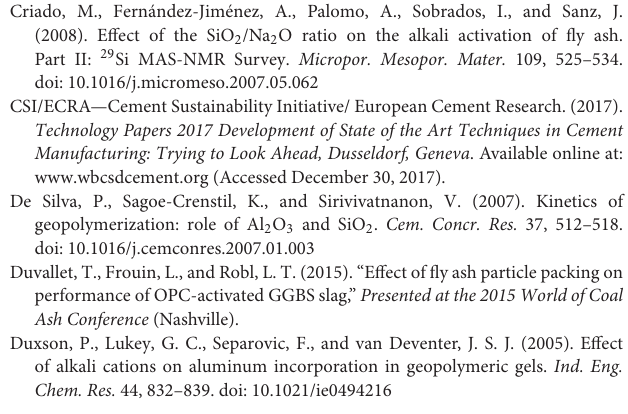
Figure S1 | SEM Micrographs of the coal fly ashes before (F1, F2 and F3) and after grinding (F1G, F2G and